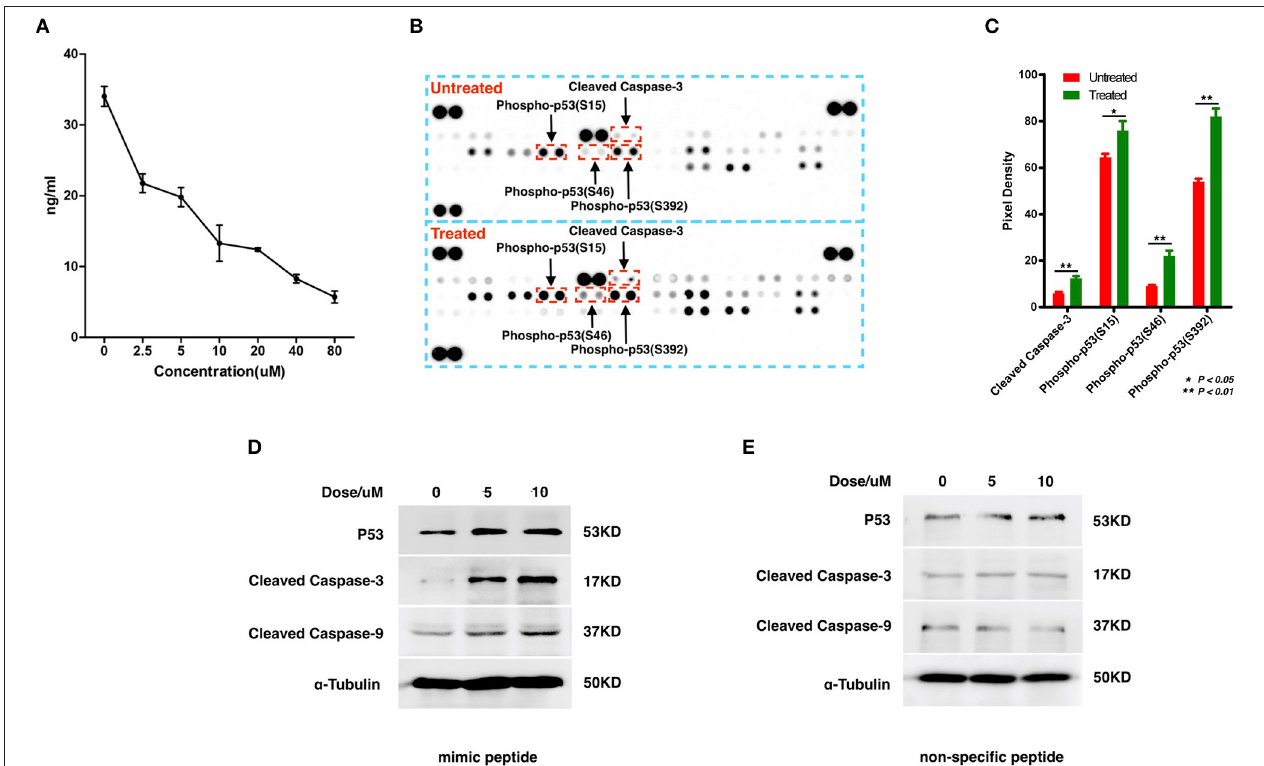
FIGURE 4 | Detection of the interaction between MDM2 and the synthetic ZCP peptide during the activation of P53-induced cell death in U87 cells. (A) Competitive inhibition effect of treatment with the synthetic peptide on intracellular free MDM2 in U87 cells. The concentration of cellular free MDM2 was determined with an ELISA. Values shown are means ± SD. (B) P53 activation and apoptotic markers were upregulated in the synthetic-peptide-treated U87 cells compared with the control in the protein array. (C) Quantification of the markers in the images shown in (B) , signals were quantified with ImageJ. (D) Activation of total P53 and apoptotic markers were confirmed with western blotting. (E) Non-specific peptide. SD, standard deviation. * P < 0.05; ** P <